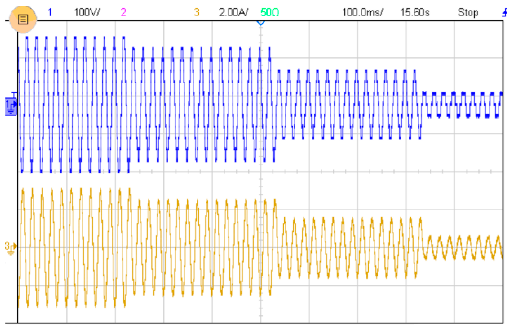
Figure 13. Experimental results ( a ) for highly inductive load and ( b ) zoomed view of load changes. Figure 14. Experimental results of 13-level inverter voltage and current for continuous load changes.